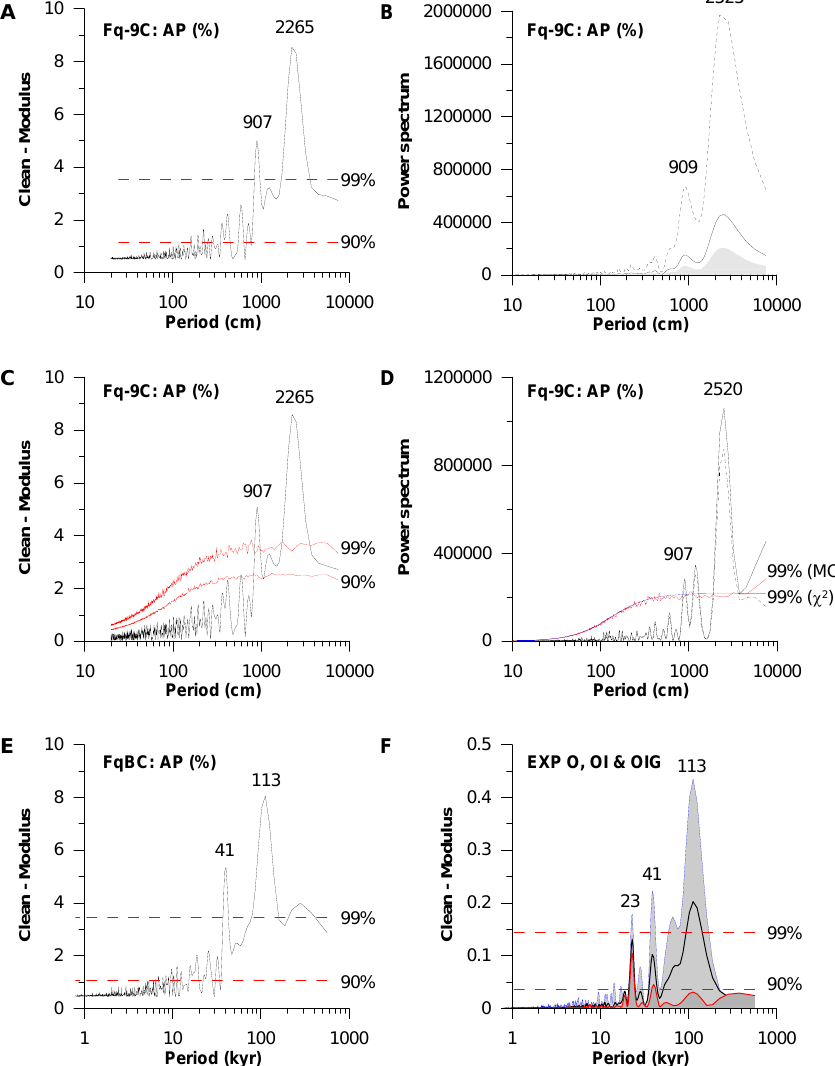
Fig. 5. Spectral analysis results of the AP% data series of core Fq-9C. (A) CLEAN. (B) Blackman-Tukey. (C) CLEAN (emended). (D) RED- FIT (see text for explanations and references). (E) CLEAN spectrum of the F´uquene Basin composite (FqBC) AP% record in the time domain. This spectrum was established by adding 10% red noise (i.e. control parameter=0.1), a clean/gain factor of 0.1, 500 CLEAN iter- ations, an interpolation step (dt) value of 0.2kyr and 500 simulation iterations. (F) CLEAN spectrum of EXPs O (red), OI (black) and OIG (blue) over the past 284000 years. Similar methods were followed as in (E) . Note that only the 90 and 99% significance levels of EXP OIG are